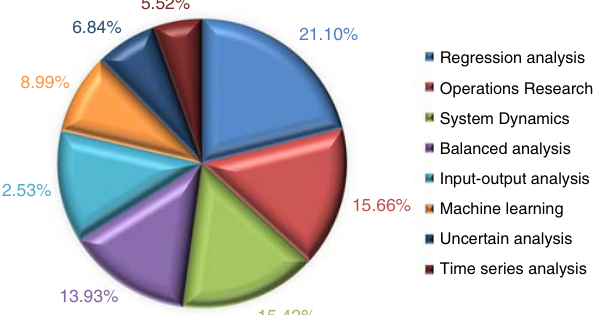
Figure 3. Proportion of marine econometrics algorithms